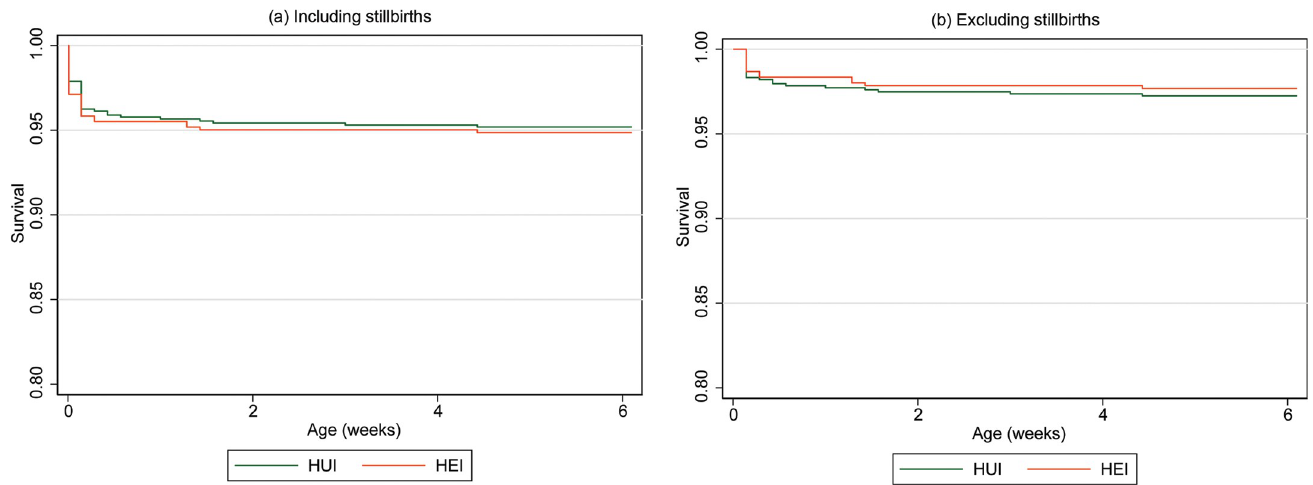
Fig 2. Survival of HUI and HEI at six weeks of age including and excluding stillbirths.